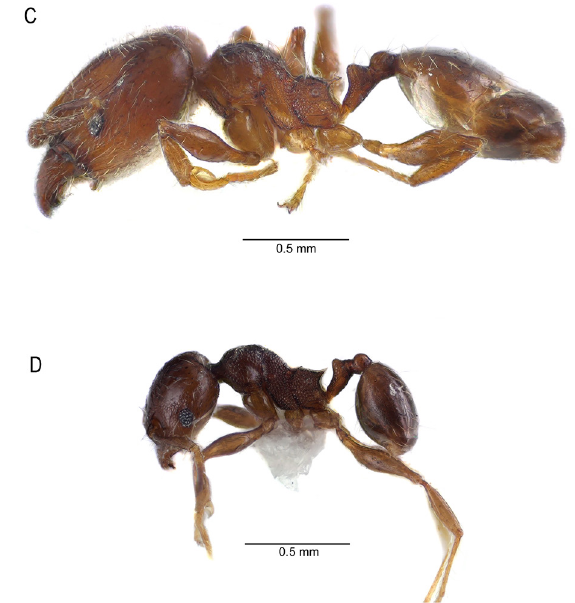
Fig 3. Pheidole protaxi sp. nov., habitus: dorsal view. E: holotype major worker, [LBSA_SA_14013667]. F: paratype minor worker, [LBSA_SA_14012040].